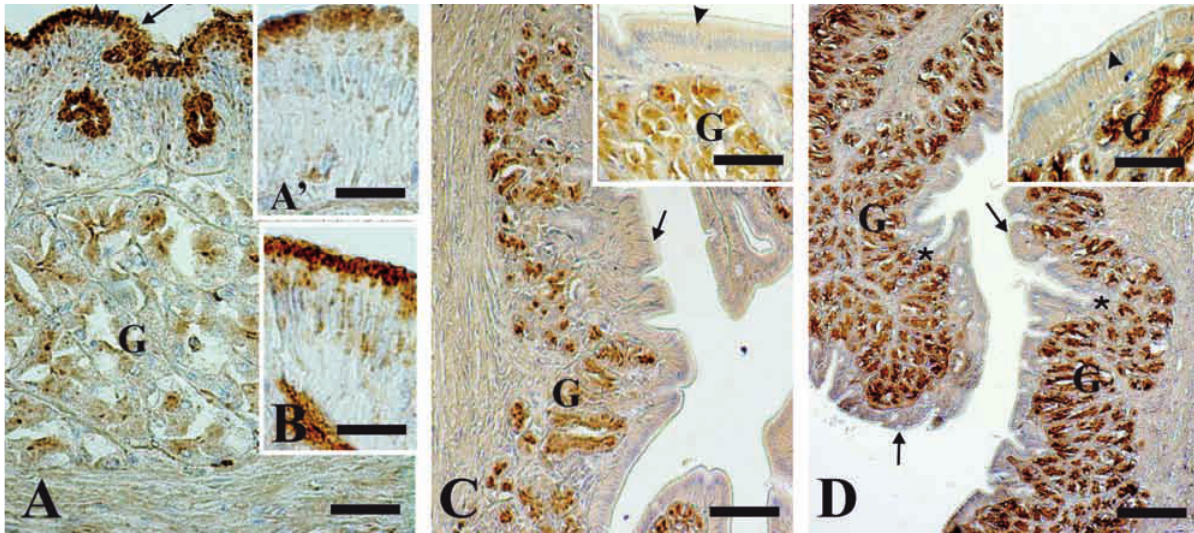
Fig . 4. – Pna (a, a’), Koh-sialidase-Pna (B), DBa (c), and Koh-sialidase-DBa (D) reactivity of the gastric mucosa of Halobatrachus didactylus . a, Pna moderately stains the luminal cell coat, the apical zone of the surface epithelial cells and the pit cells as well as the gastric glands. Scale bar: 52 μm. a’ and B show the staining of the surface epithelial cells with Pna and Koh-sialidase-Pna staining, respectively. note the increased Pna staining after Koh-sialidase pre-treatment. Scale bars: a’ and B, 15 μm. c, DBa shows a very faint reaction with a thin supra-nuclear zone of the surface epithelial cells and with the sub-nuclear cytoplasm of the pit cells, whereas it moderately stains the gastric glands. Scale bar: 90 μm; scale bar of inset: 50 μm. D, after Koh-sialidase treatment the DBa staining shows increased reactivity (compared with c). Scale bar: 180 μm; scale bar of inset: 50 μm. G, gastric gland; arrow, surface epithelial cells; arrowhead, supra-nuclear zone; asterisk, epithelial